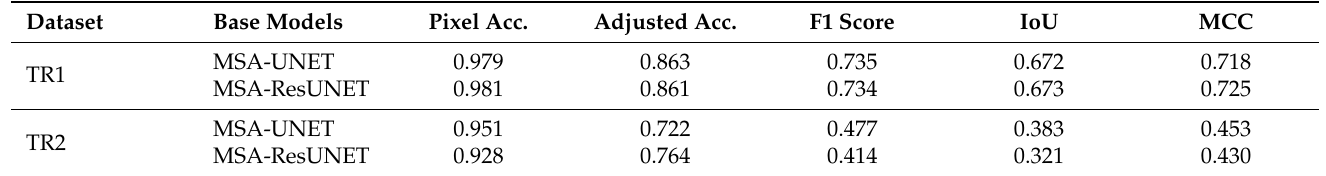
Table 1. Same-domain validation results of MSA-UNET and MSA-ResUNET. Dataset Base